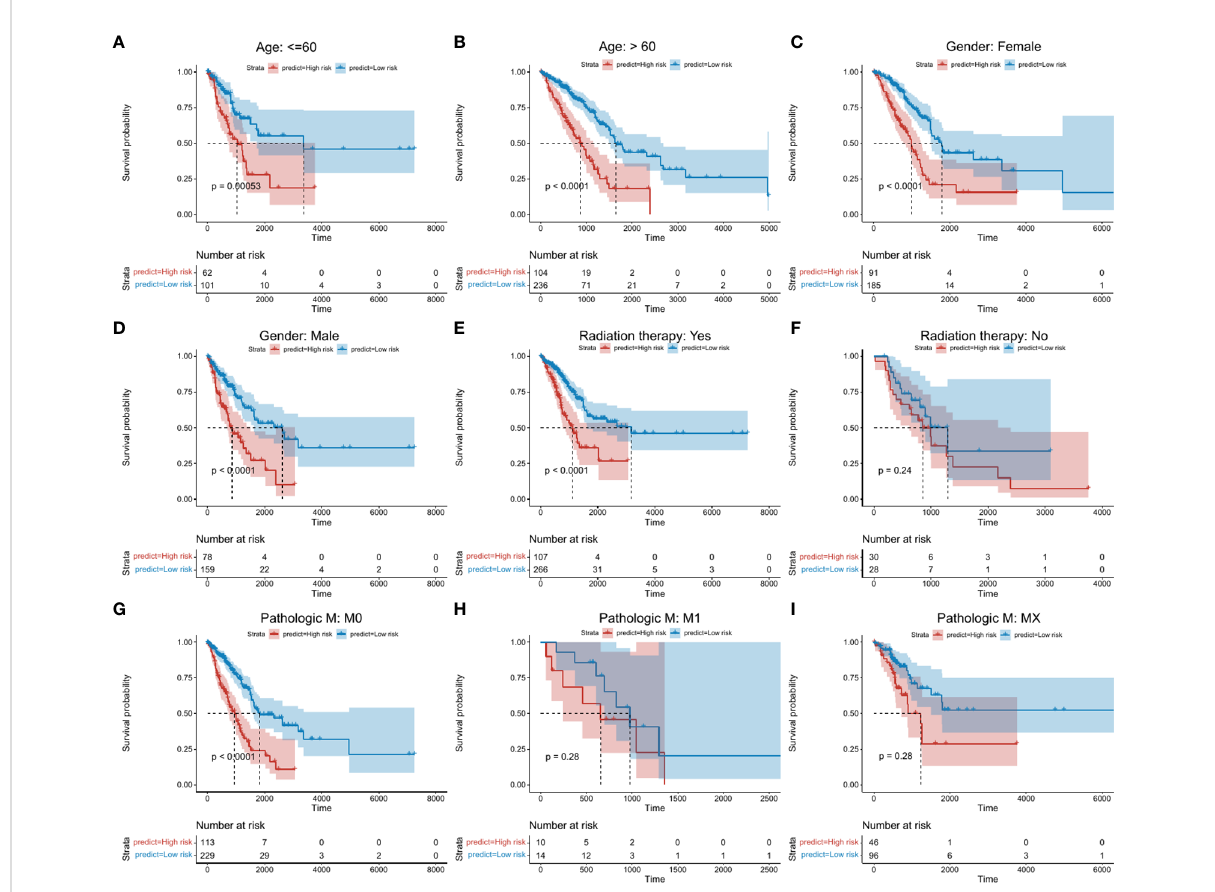
FIGURE 4 Kaplan-Meier survival analysis between high- and low risk groups. Abscissa axis: survival time; Ordinate axis: survival probability. Colors: different risk groups. (A) Kaplan-Meier survival analysis between high- and low-risk groups in those aged ≤ 60 years. (B) >60 years. (C) Female